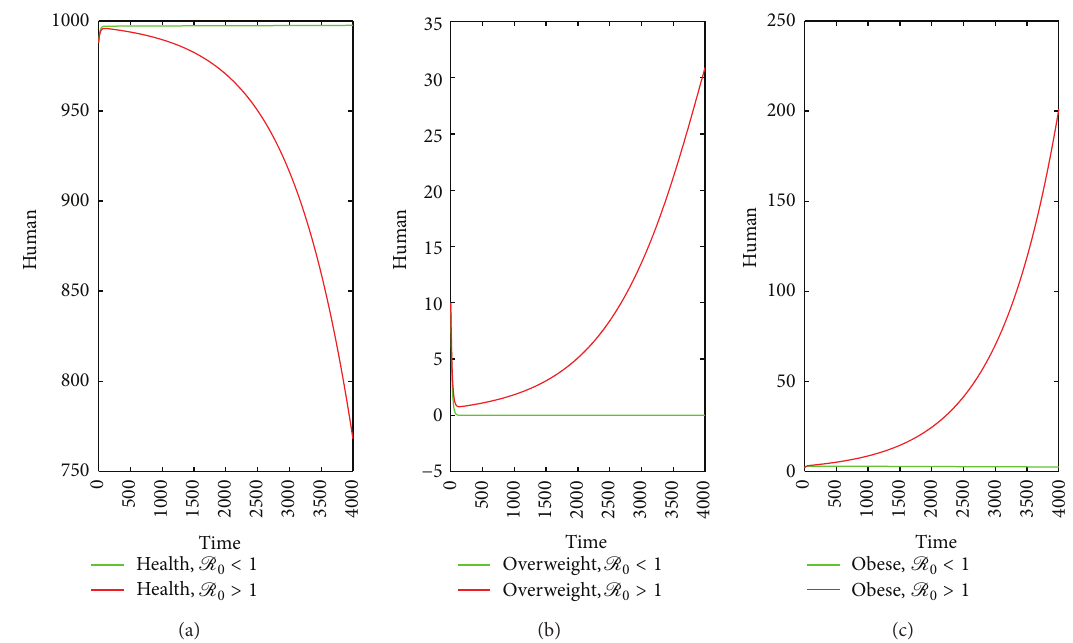
Figure 5: Numerical simulations of healthy (a), overweight (b), and obese (c) compartments when R 0 < 1 and R 0 > 1 . same. From Figure 3(b), it can be seen that intervention of treatment and health life campaign together success to minimize number of obese people. In the other hand, because number of obese people decrease, total number of overweight people is increasing because of success of the treatment for obese people (see Figure